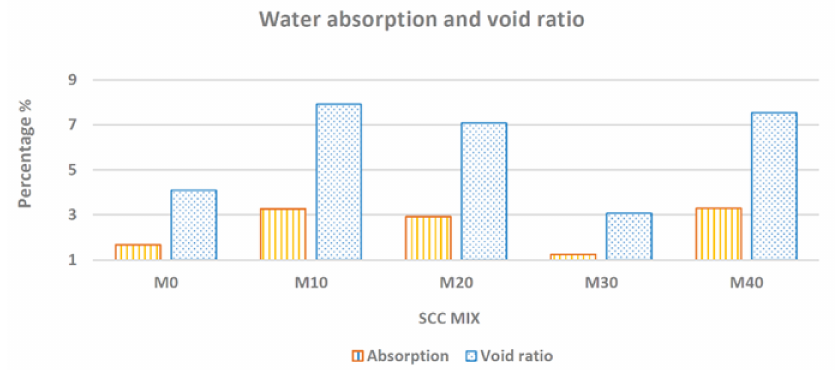
Figure 10. Water absorption and void ratio of different SCC mixtures.